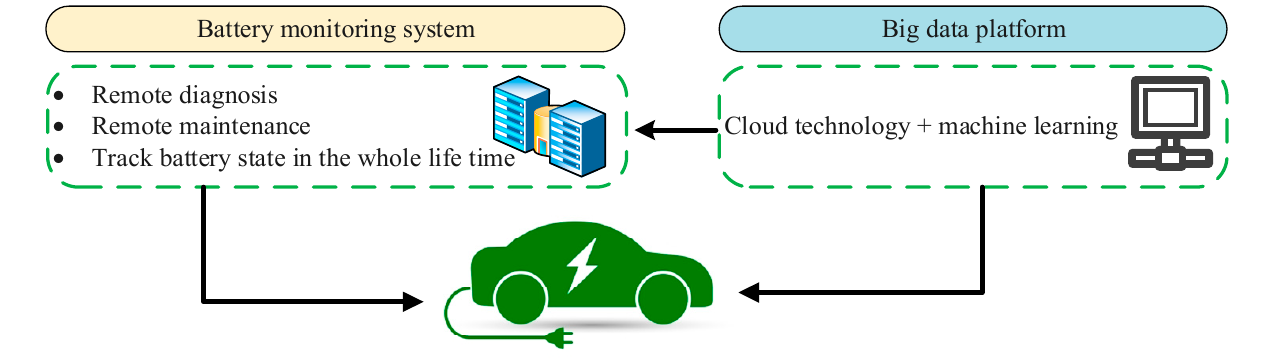
Figure 3. BMS-based cloud-integrated data acquisition framework for EV technology.